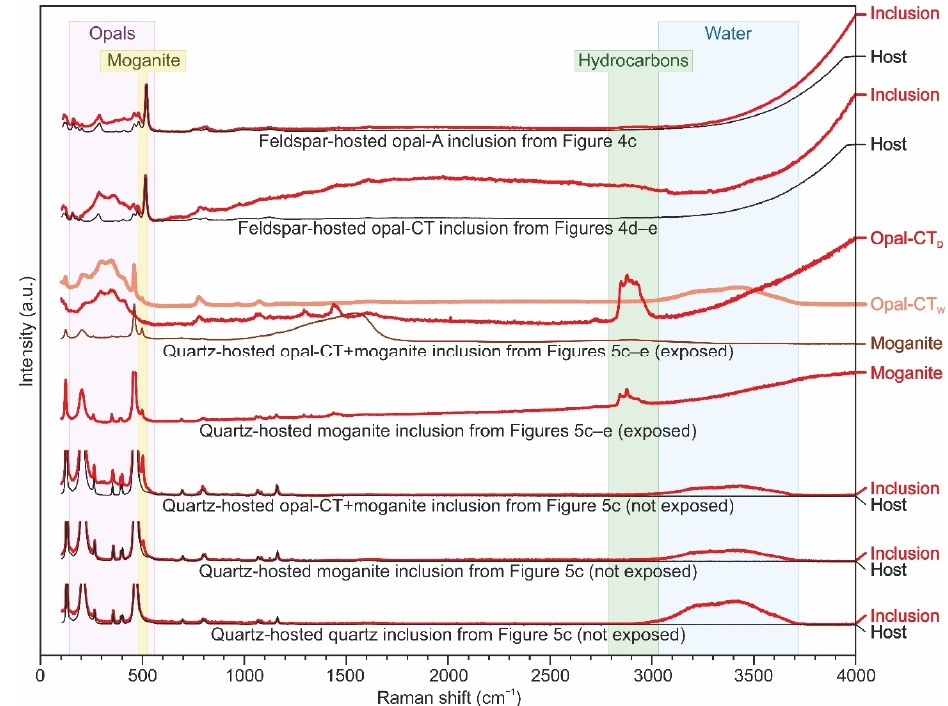
Figure 7. Representative Raman spectra of SiO 2 -rich fluid inclusions. Spectra labelled as opal and moganite are from the exposed inclusions in Figure 5c–e. The upper spectrum labelled as moganite was acquired after BSE imaging when the sample surface was coated with carbon, which explains the presence of the band between 1100–1700 cm − 1 . The locations of the diagnostic Raman bands for moganite, opals, hydrocarbons and water are highlighted.